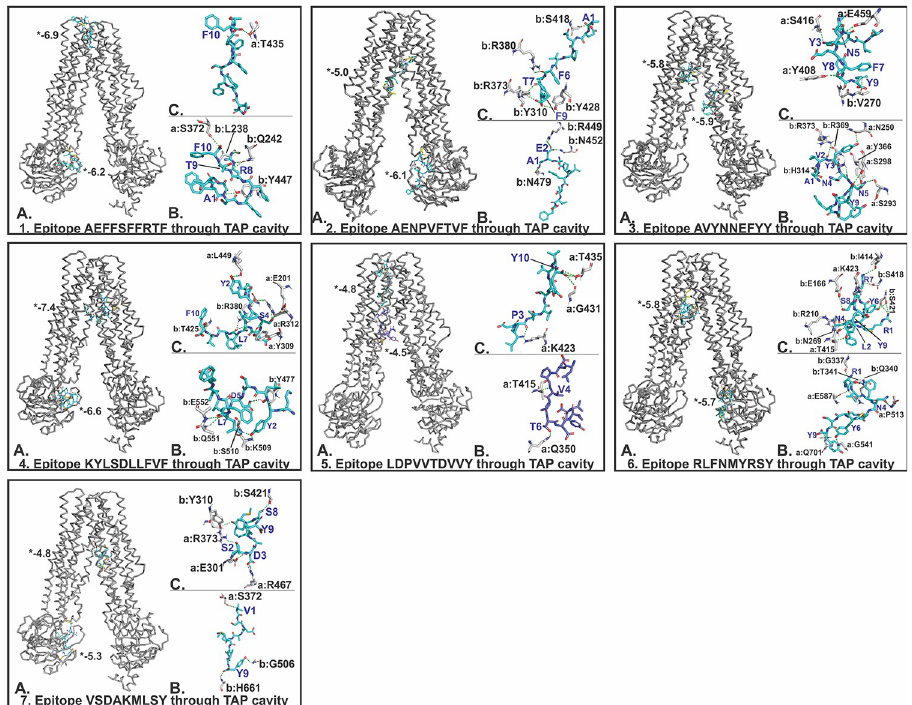
Fig 4. Molecular docking analysis of CTL epitopes within the TAP transporter cavity. Molecular interaction of the seven selected CTL epitopes (cyan sticks) with the TAP cavity (gray ribbon/sticks) is shown in detail. Panel (A) shows the binding of epitope at two different sites within TAP cavity, panel (B) and (C) show detailed molecular interaction between epitopes and TAP cavity; (a, b) show chain A and B of TAP transporter. H-bonds are highlighted as yellow dots. ( � ) Indicates binding energy, shown in